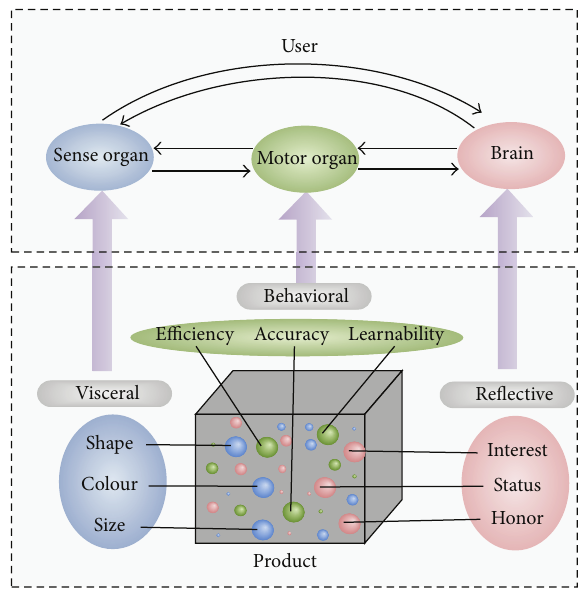
Figure 1: Emotional design classification and